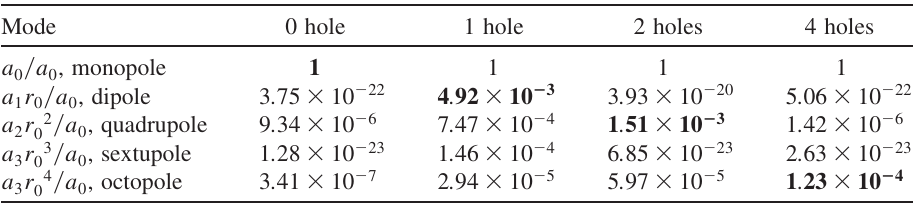
TABLE I. Fourier coefficient ( a n r n ) of E z for the models in Fig. 1. The dominant mode in each case is boldfaced. These values are computed at the position z ¼ 61 mm , which is the center of the full cell, and the radius r 0 ¼ 9 : 5 mm